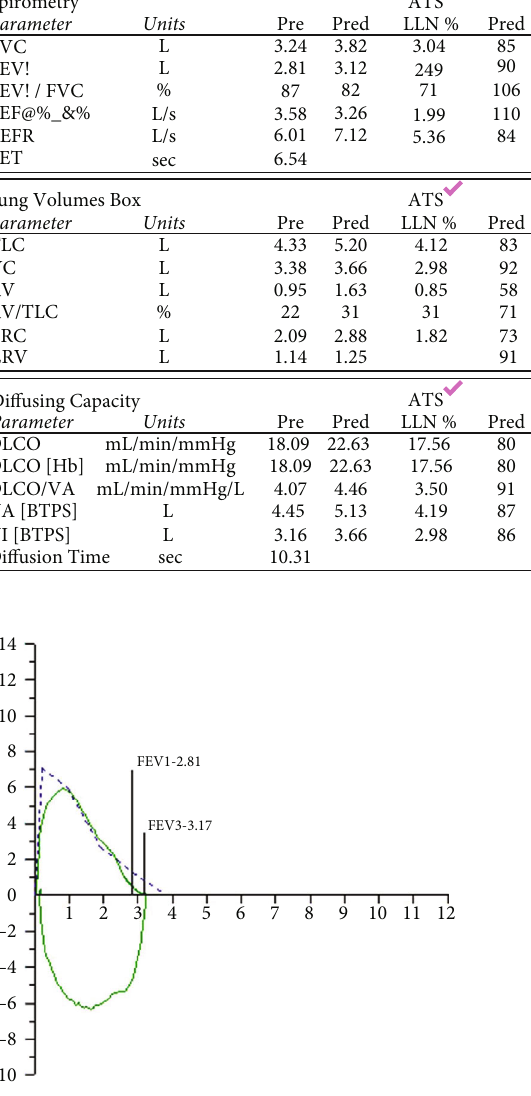
Figure 4: Normal spirometry, lung volumes, and di ff using capacity six months after initial